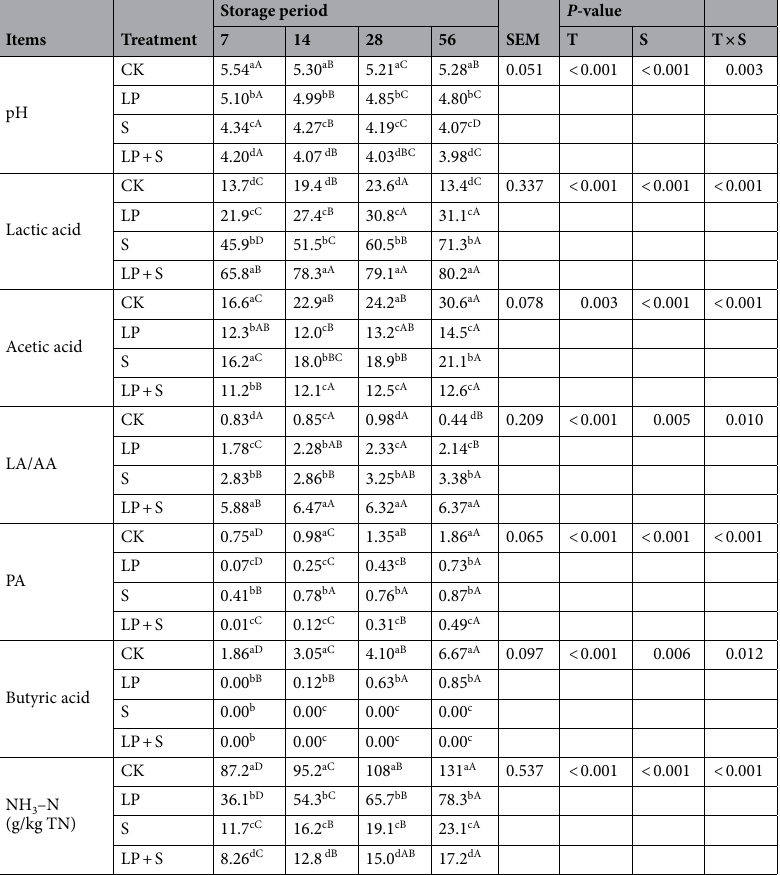
Table 2. Effect of different additives on fermentation quality (g/kg DM) of alfalfa silage during ensiling. a-d Means within a column with different superscripts differ ( P < 0.05); A-E Means within a raw with different superscripts differ ( P < 0.05). LP, Lactobacillus plantarum ; S, sucrose; LP + S, the addition of both sucrose and Lactobacillus plantarum ; TN, total nitrogen; DM, dry matter; FM, fresh matter; LA/AA: lactic to acetic ratio; PA, propionic acid; T: effect of treatment; S: effect of storage period; T × S: interaction between treatment and storage period; SEM, standard error of